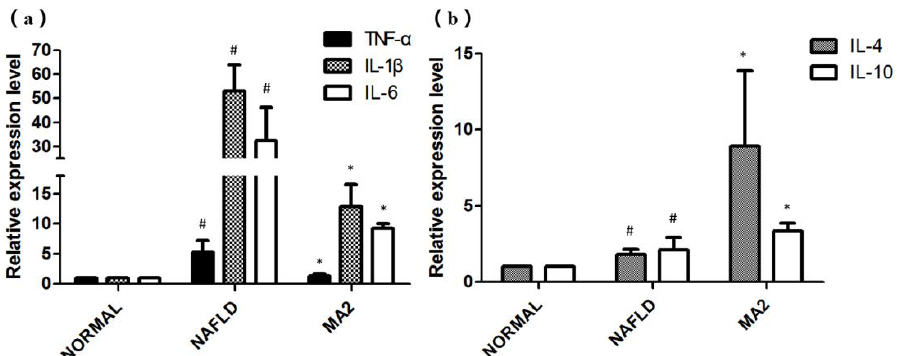
Figure 6. The influence of L. plantarum MA2 on the relative expression levels of inflammatory factors in rats. ( a )TNF- α , IL-1 β and IL-6 and anti-inflammatory factors; ( b ) IL-4 and IL-10. (# indicates p < 0.05 compared with the normal group; * indicates p < 0.05 compared with the NAFLD group. NORMAL: normal group, NAFLD: non-alcoholic fatty liver disease, MA2: L. plantarum MA2 treatment group).